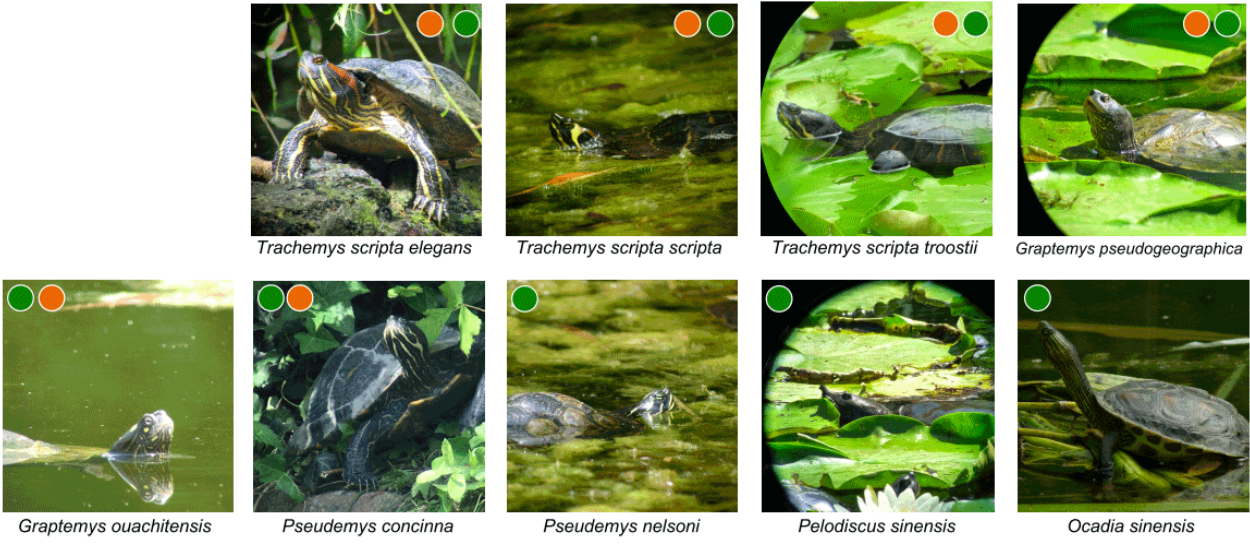
Fig. 2. Exotic turtle species identified in the two urban parks in Strasbourg, France (Citadelle in green, Orangerie in orange) studied by Philippot et al.